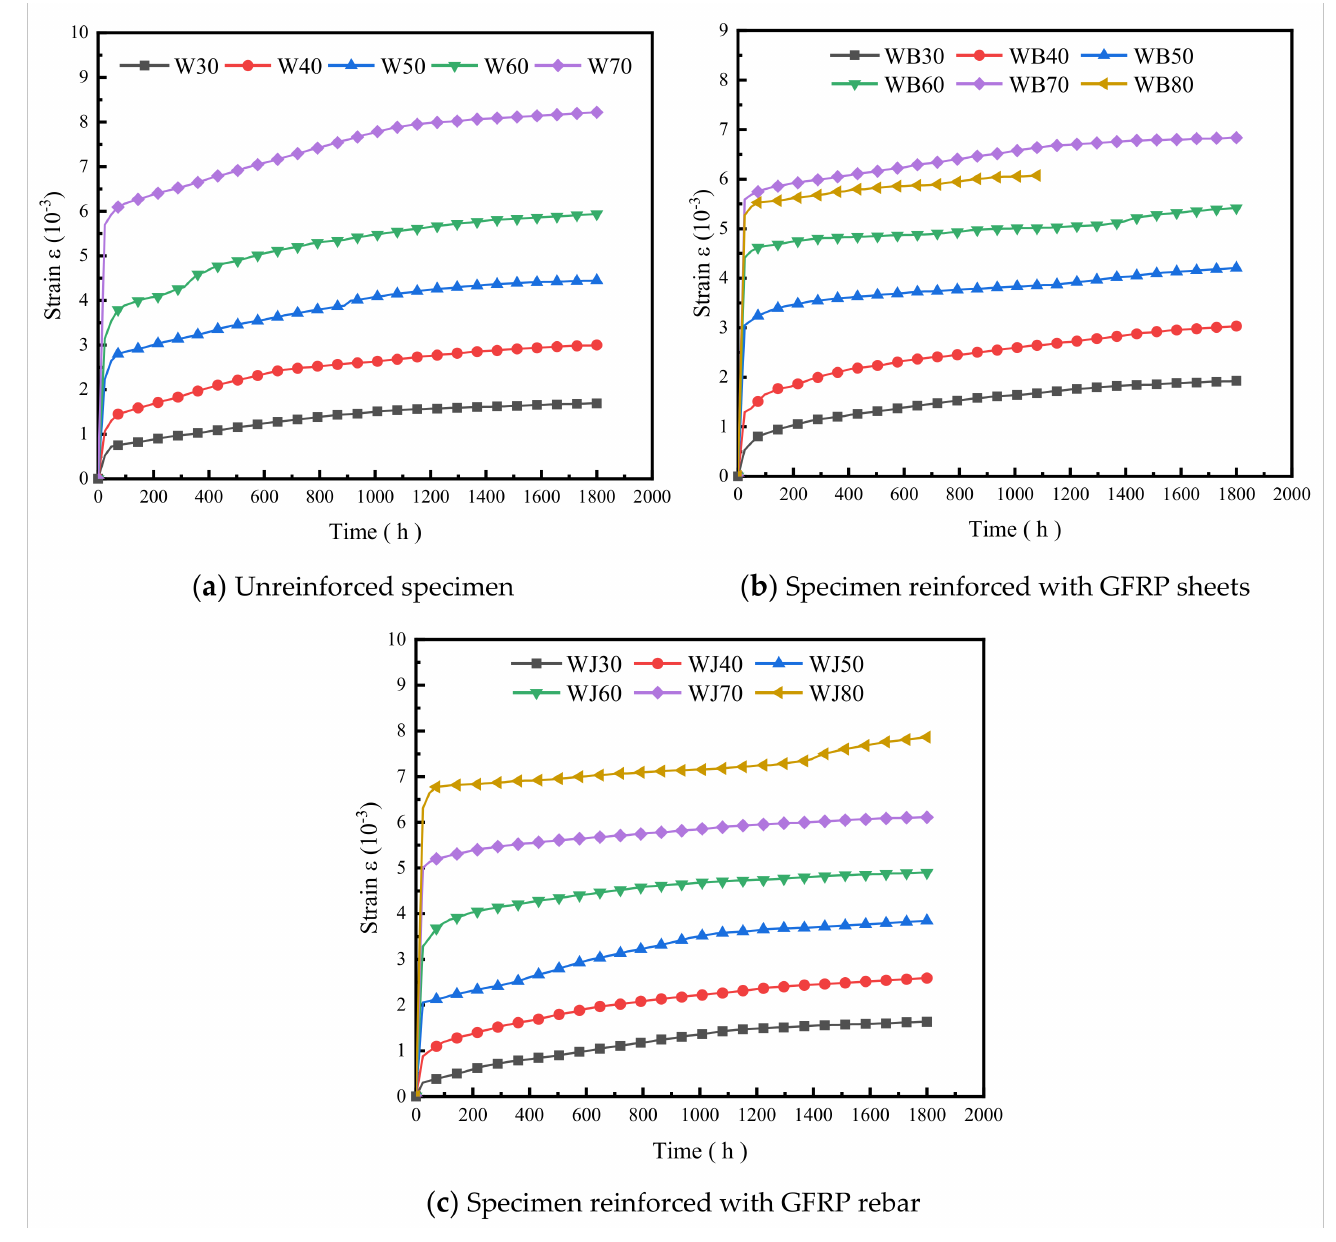
Figure 6. Bending creep strain–time curve of PVC-based WPCs (W represents the unreinforced WPC specimen type, WB represents the type reinforced with GFRP sheets, and WJ represents the type reinforced with GFRP